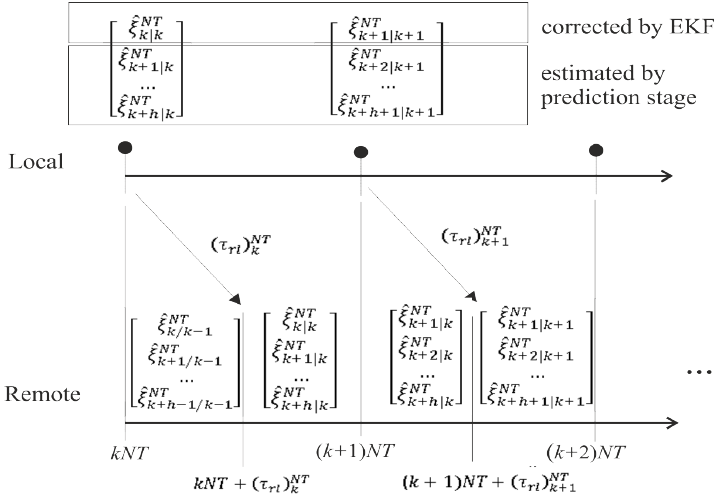
Figure 3. Time axis example for the local-to-remote